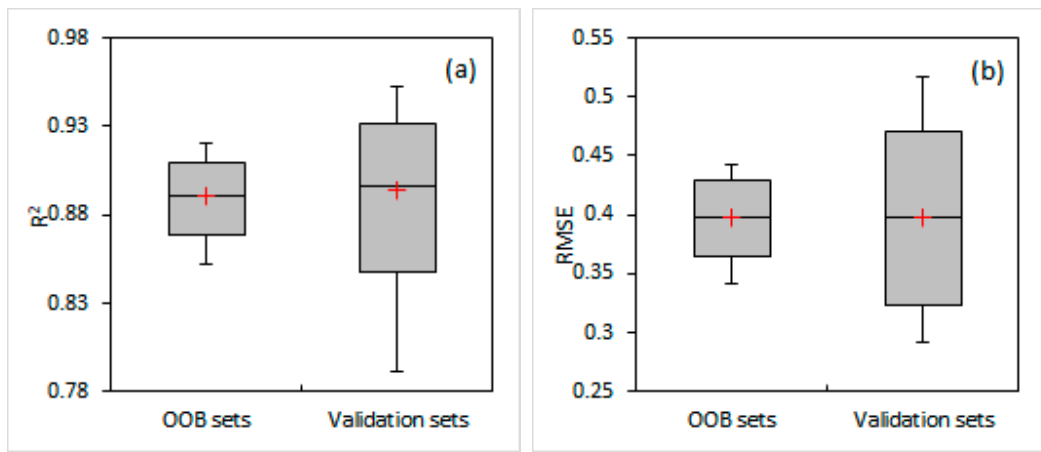
Figure 3. Range of ( a ) R 2 and ( b ) RMSE of the Out-of-Bag (OOB) and validation sets of the multiple random forests (MRF) analysis presented as modified box-whisker plots, with boxes adjusted to the 95% HPD interval.